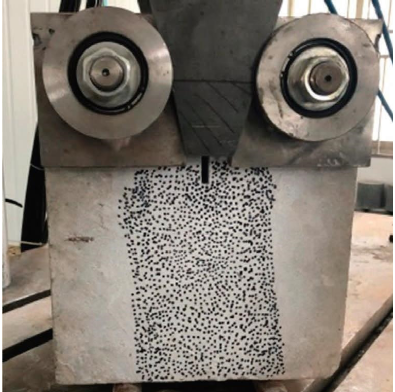
Figure 2: Specimen surface with